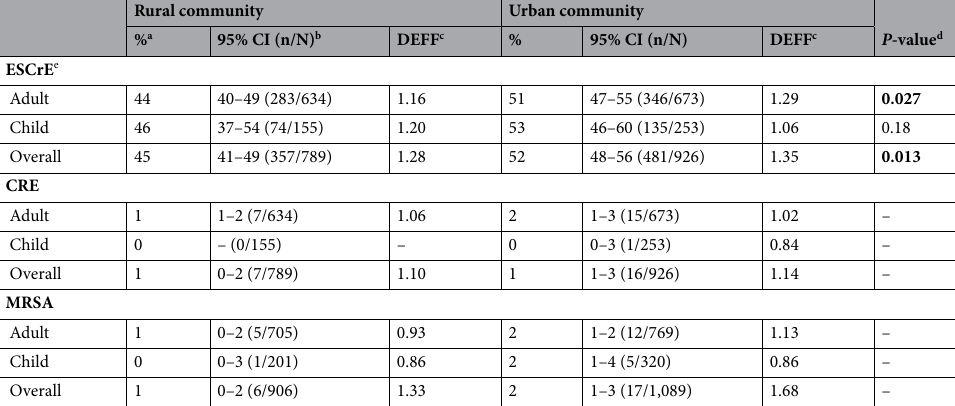
(Table 1). The ranges for estimated design effect for CRE and MRSA varied widely (including < 1.0), consist- ent with non-asymptotic variance estimates that can be expected with small numbers of colonized individuals (range 0–17 participants depending on category, Table 1). The overall prevalence of ESCrE-colonization among community participants was significantly lower for rural vs. urban sites (45 and 52%, respectively, P = 0.013, Table 1), and significantly lower for rural hospitals compared with urban hospitals (63 and 70%, respectively, P = 0.032, Table 2). ESCrE prevalence was 18% higher in the rural hospitals compared to the rural community with non-overlapping 95% confidence intervals (Tables 1 and 2). ESCrE prevalence was 18% higher in the urban hospital compared to the urban community with non-overlapping 95% confidence intervals (Tables 1 and 2). When examined by age group and stratified by community, hospital, urban and rural, prevalence estimates for ESCrE differed by < 5% between adults and children (Tables 1 and 2). Adults in the urban community had a statistically higher ESCrE prevalence (51%) compared to those in the rural community (44%; P = 0.027, Table 1). Children in urban hospitals had a statistically greater colonization rate (72%) compared with children in rural hospitals (61%; P < 0.021, Table 2). The prevalence of CRE was < 2% in urban and rural communities (Table 1)